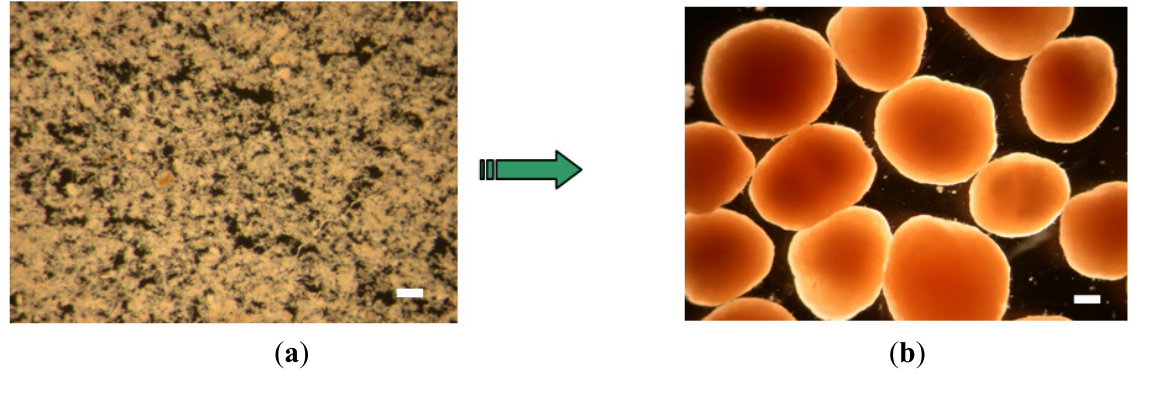
Figure 3. Microscopic examination of sludge and granules (scale bar = 1 mm). ( a ) Inoculum (floc sludge); ( b ) Aerobic granules at the 135th